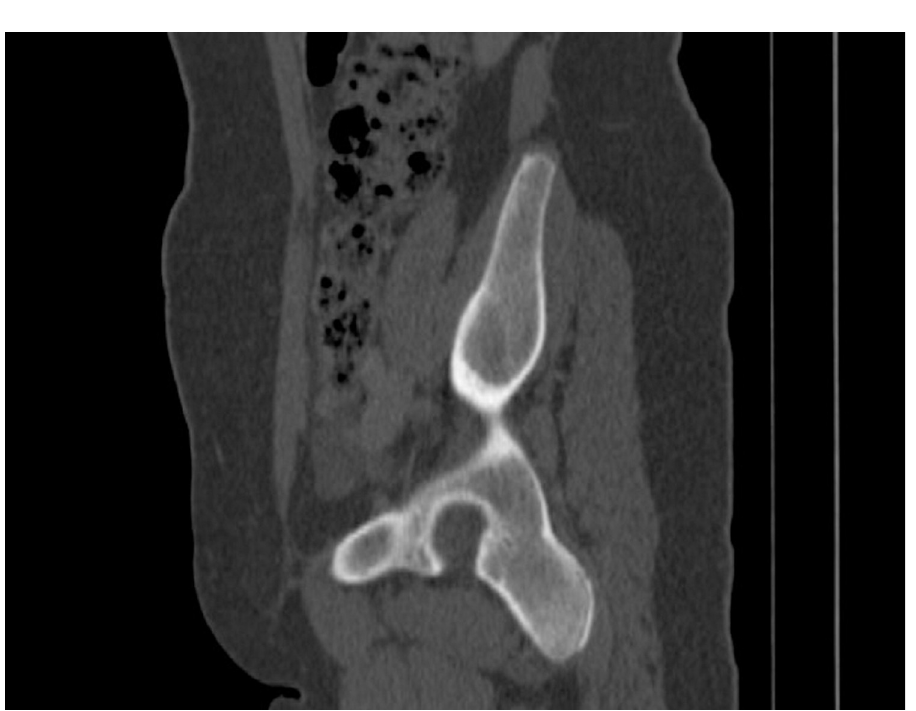
Fig 4. For a patient who is a 16-year-old boy, the sagittal plane reformatted computed tomography image shows that all three synchondrosis regions are closed.